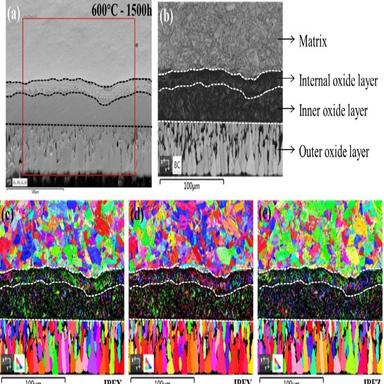
Cross-sectional SEM-EBSD images of the surface oxide film on T91 exposed to SCW for 1500 h at 600 °C. (a) SEM image, (b) pattern quality image, and (c-e) IPF images of the surface oxide.